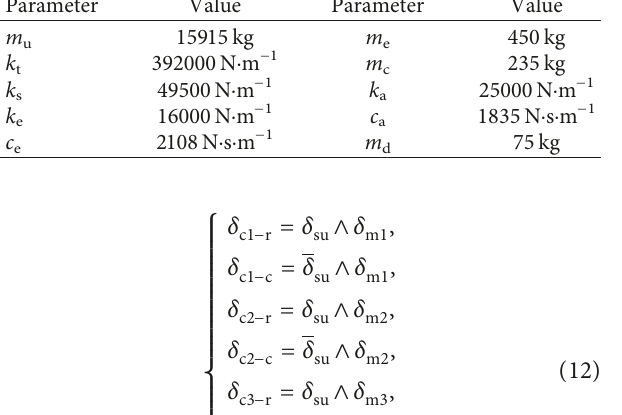
Table 3: Parameter values of the vibration model of the wheel loader.